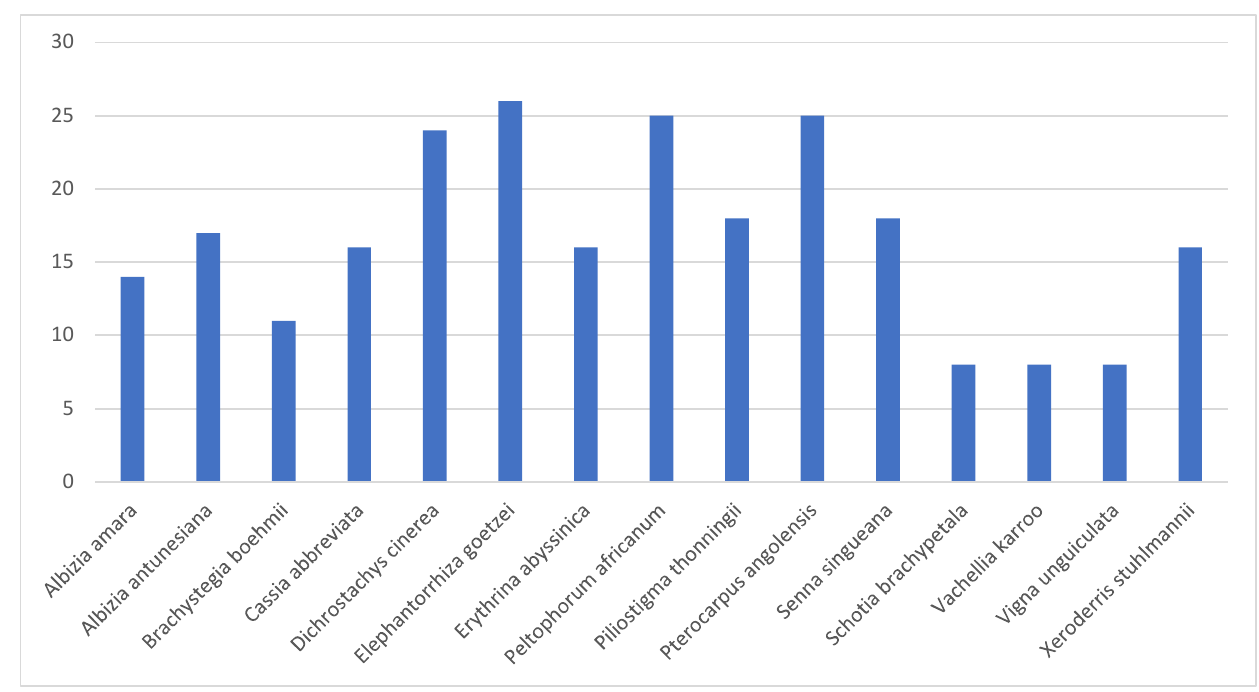
Figure 4. Fabaceae species with eight or more usage reports cited in at least four references.